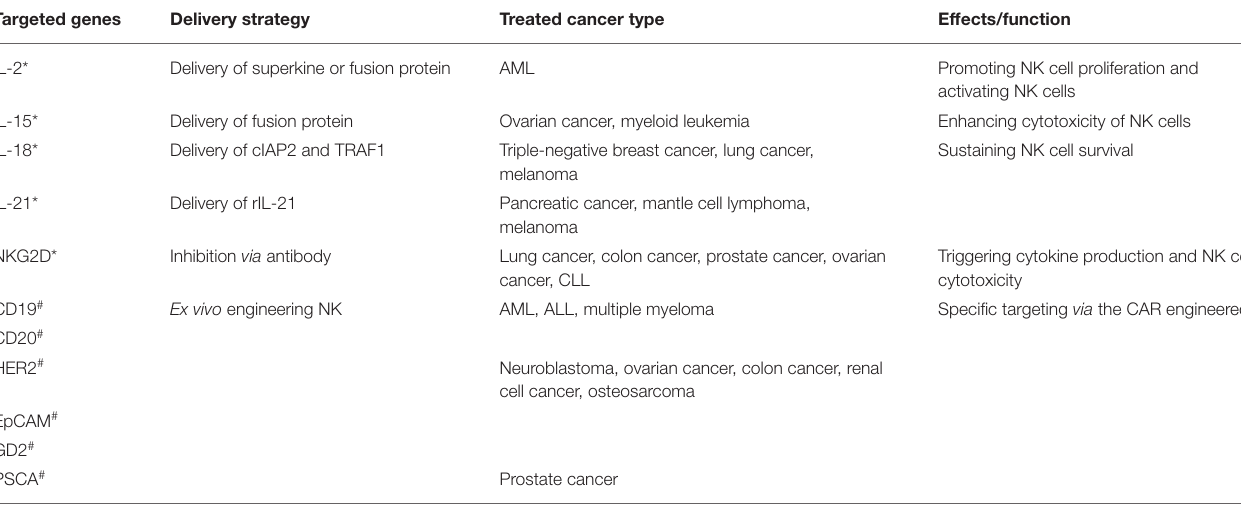
TABLE 4 | Natural killer (NK) cell-based immune therapy. Targeted genes